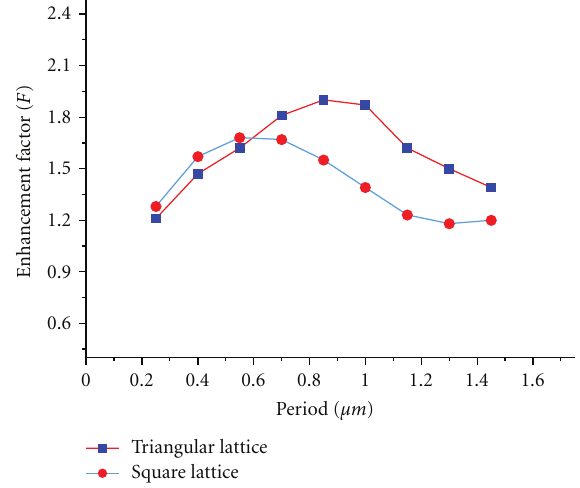
Figure 4: The enhancement factor of triangular lattice PhCs and square lattice PhCs as a function of